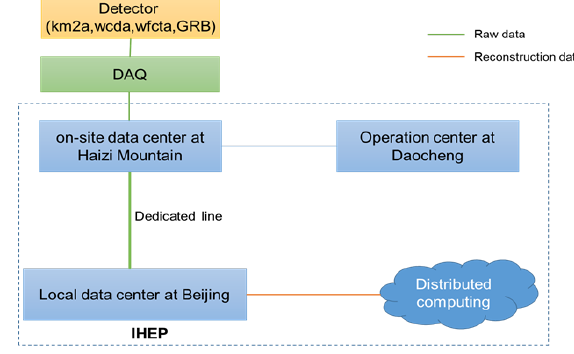
Figure 1. LHAASO dataflow